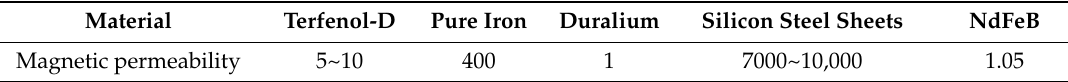
Table 2. Permeability of Different material.